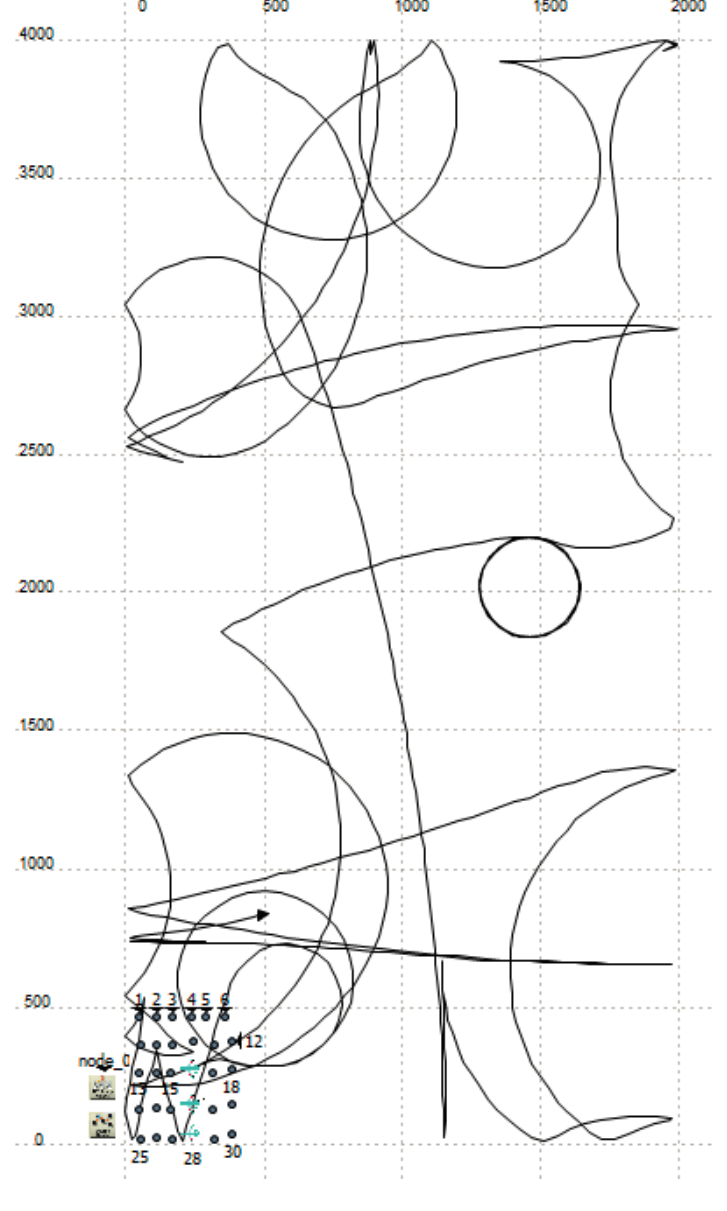
Figure 3. Trajectory of a UAV under the smooth-turn (ST)